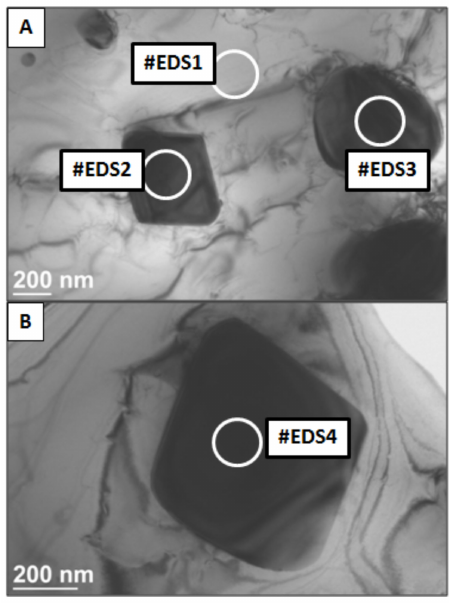
Figure 8. Transmission electron microscopy (TEM) image with four areas analyzed by EDS: ( A ) small precipitates ( B ) large precipitate.